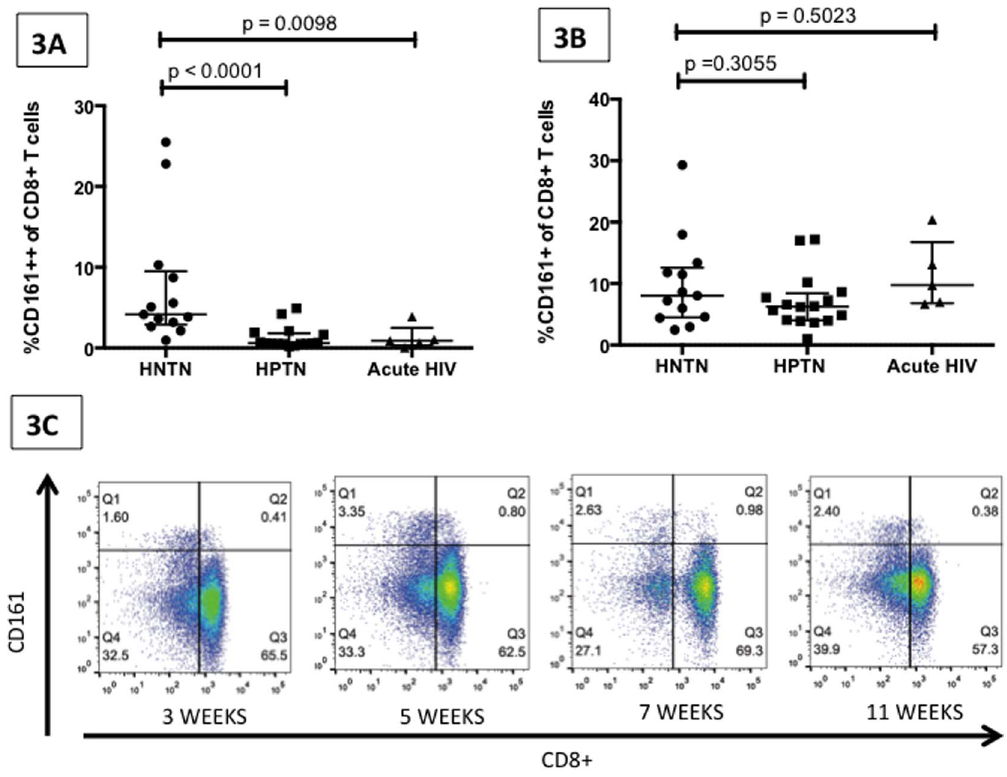
Figure 3. Acute HIV infection is associated with a lower frequency of CD161 ++ CD8 + T cells. Figure 3A: Graph displays CD161 ++ CD8 + T cell frequency in HIV negative and TB negative subjects (HNTN, n= 13), individuals with chronic HIV infection (HIV positive TB negative HPTN, n=16), and individuals in the acute phase of HIV infection (n=5, sample taken within 2–3 weeks of presumed infection date). CD161 ++ CD8 + T cells are significantly lower in HPTN individuals and those with acute HIV. Figure 3B: Graph displays CD161 + CD8 + T cell frequency in the same three groups of subjects; CD161 + CD8 + T cells do not show any differences between these three groups. Figure 3C: A representative FACS plot displaying the CD161 ++ CD8 + T cell population over time in an individual acutely infected with HIV and assessed at 5 timepoints. Both graphs show median and interquartile range; p-values are reported for two-sided Mann-Whitney tests with threshold for significance p=0.025 after Bonferroni correction for 2 comparisons.